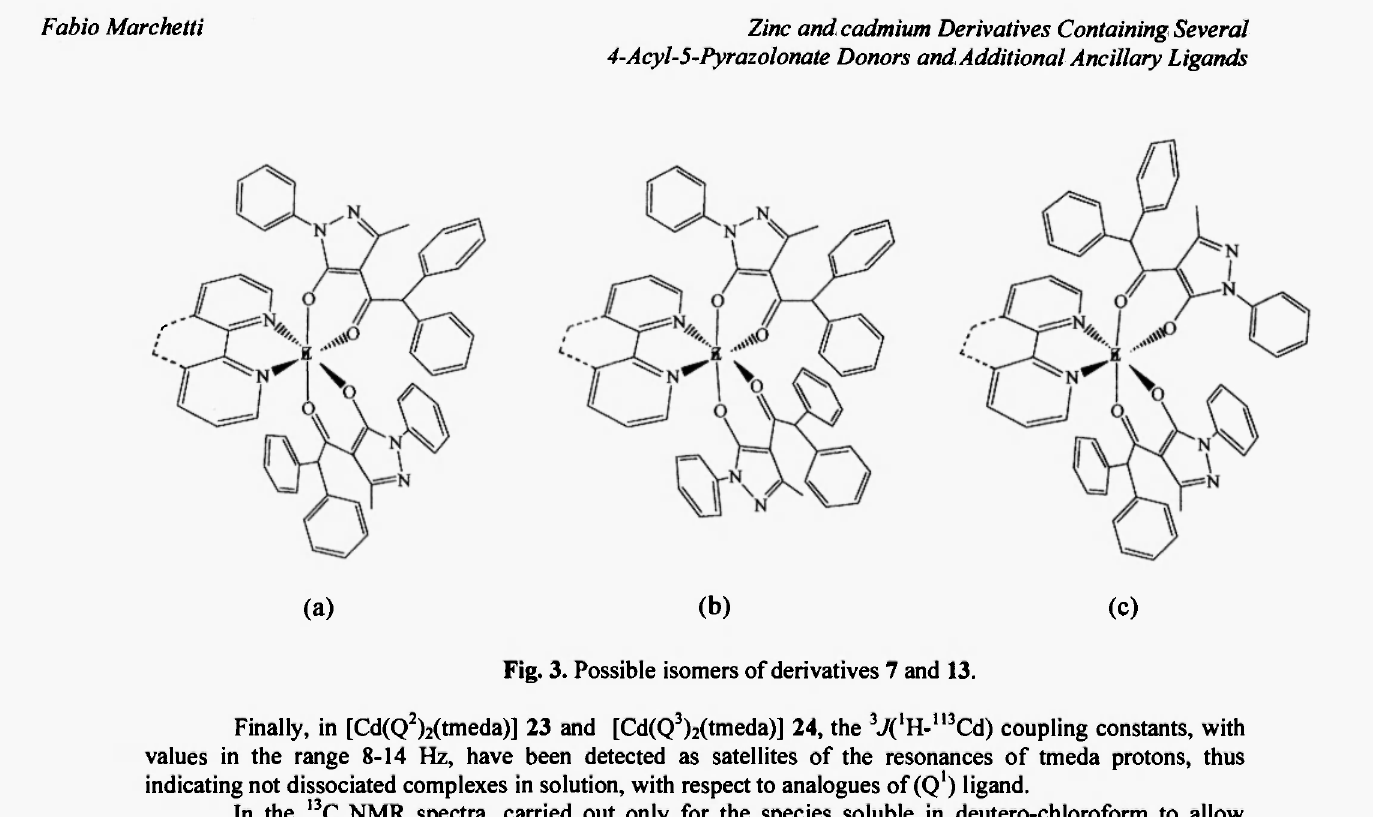
Fig. 3. Possible isomers of derivatives 7 and